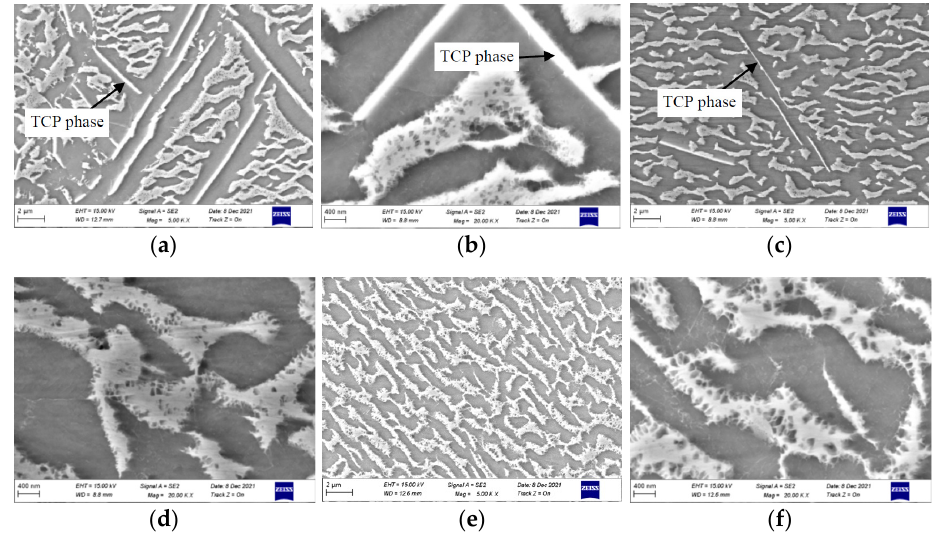
Figure 11. Microstructure adjacent to the fracture surface of the ruptured samples at 1140 °C/137